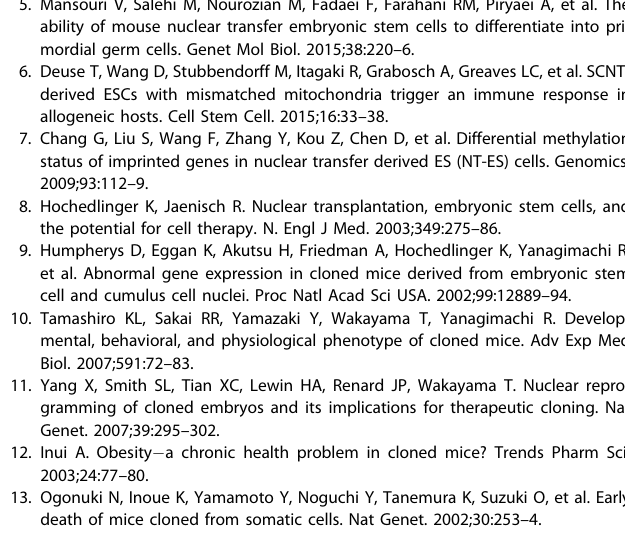
Fig. 8 A schematic model showing the 3D genome reorganization during SCNT reprogramming. ntESCs are used to replace SCNT blastocysts to build high-quality Hi-C data. Signi fi cant differences in the chromatin accessibility and chromatin structures at all three layers (compartments, TAD boundaries and loops) in ntESCs. And abnormal chromatin structures impair the differentiation process of ntESCs. H3K9me3-marked TADs show lower intensities and may affect the exact establishment of chromatin structures in